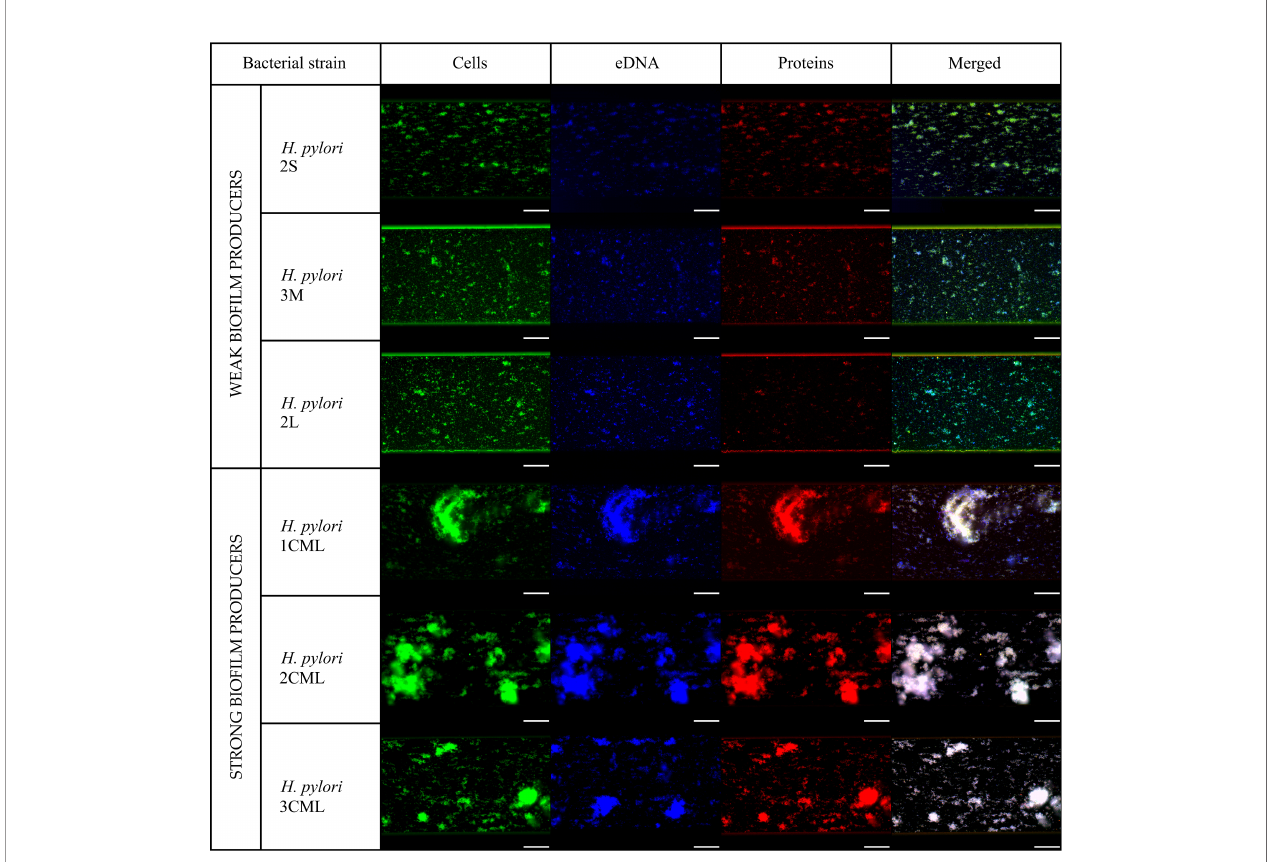
FIGURE 3 | Representative fl uorescence microscopy photographs of bio fi lms produced by six selected H. pylori strains incubated for 24 h under micro fl uidic conditions. Bio fi lms were stained by SYTO9 (green), DAPI (blue) and SYPRO RUBY (red) to enable determination of the bacterial biomass, extracellular DNA and extracellular proteins of the bio fi lm matrix, respectively. Scale bars show 20